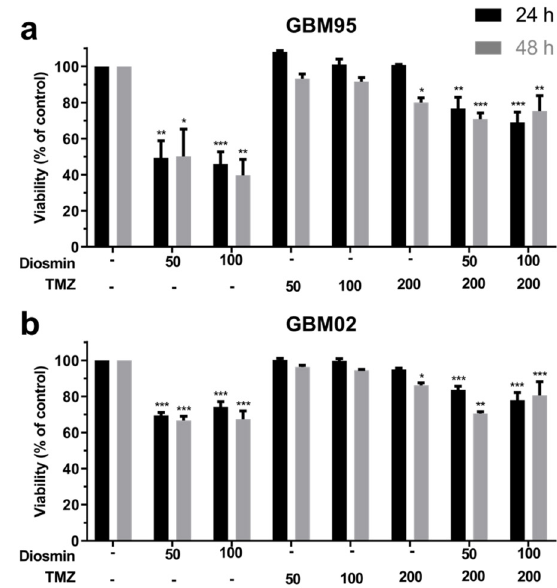
Figure 3 - Combination of diosmin and TmZ reduced cell viability without synergistic effect. Cell viability was assessed by mTT reduction assay. Graphs represent the percentage of viable cells, compared to the control (dmSO residue). Glioblastoma cells were treated for 24 and 48 hours with diosmin at 50, and 100 μM; TMZ at 50, 100, and 200 μM; and diosmin at 50 μM or 100 μM combined with 200 μM TmZ. Representative graphs of the viability of GBm95 ( a ) and GBm02 ( b ) cells. Results represent mean ± Sem of three independent experiments, each performed in triplicate (*p <0.05; **p <0.01; ***p